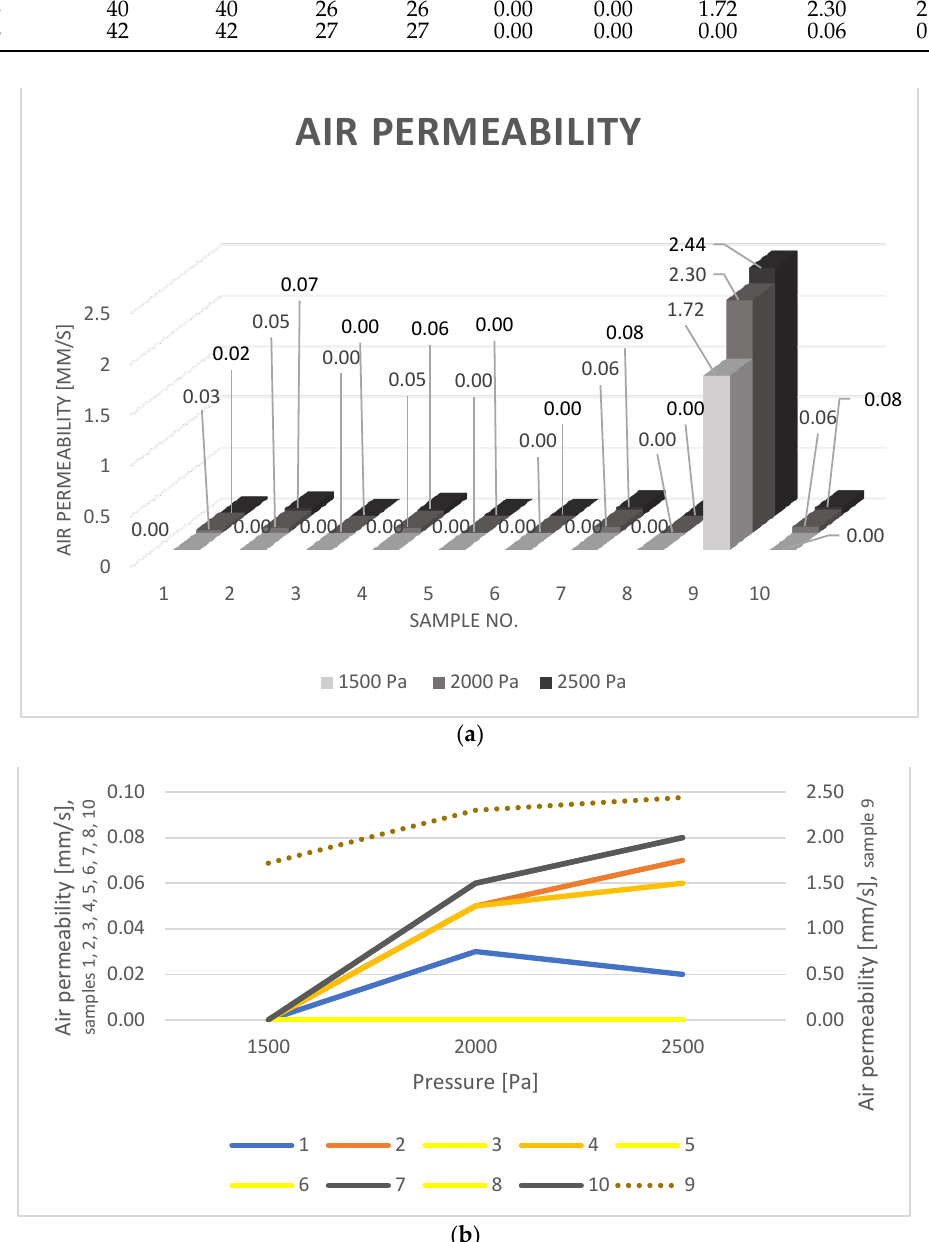
Figure 3. Obtained air permeability values, with pressure drops: 1500 Pa, 2000 Pa, 2500 Pa; ( a ) — 3D bar chart; and ( b ) — 2D linear graph with two air permeability ranges. Table 3. Fabric characteristics obtained during the laboratory tests.